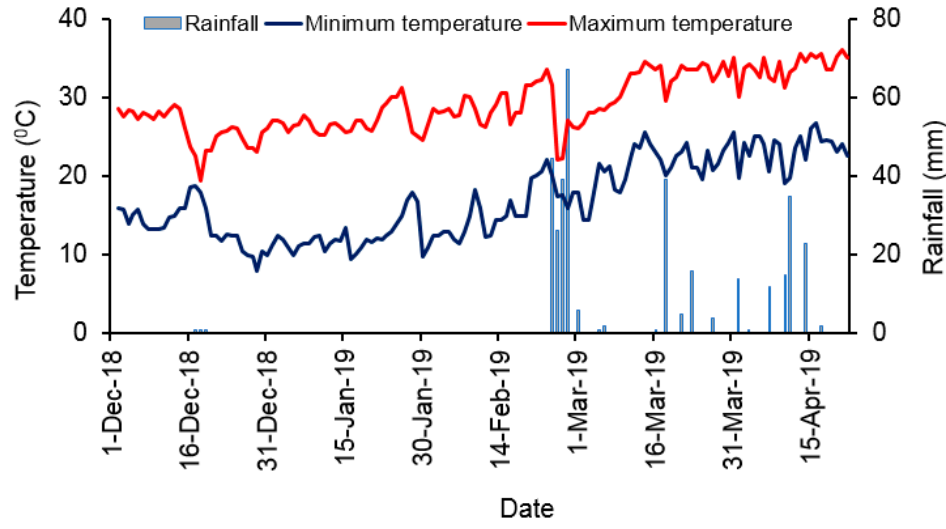
Figure 1. Weather details (daily rainfall, minimum and maximum temperature) for the 2018–2019 growing season at Pankhali, Dacope Khulna, Bangladesh. Table 1. Physicochemical properties of the soil in Pankhali, Dacope, Khulna, Bangladesh in 2018–2019.